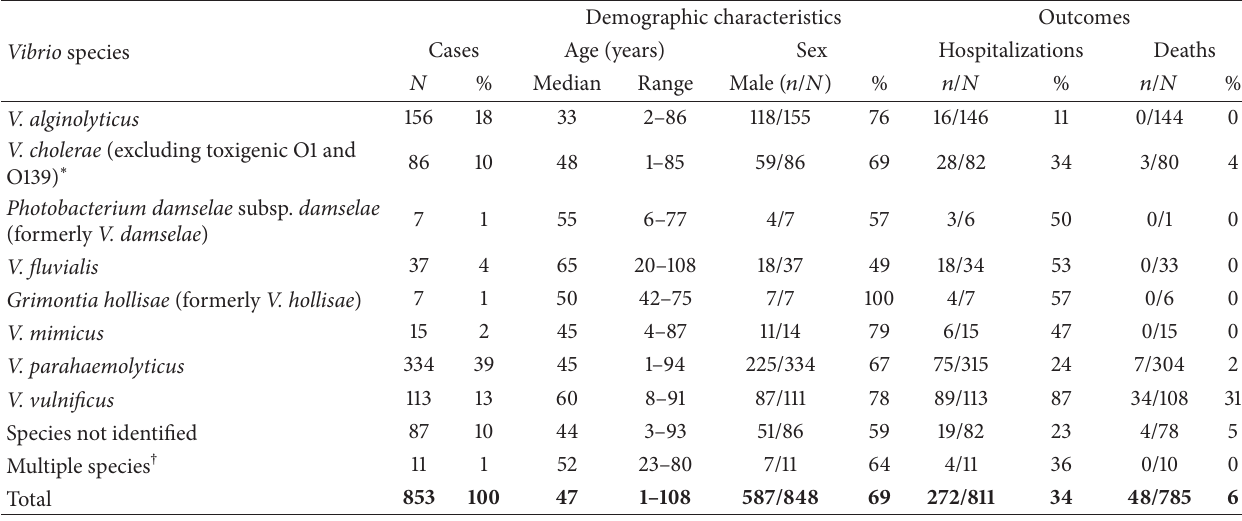
Table 1: Reported Vibrio cases in the United States in 2011, taken directly from the 2011 COVIS annual report published in the CDC website [6].